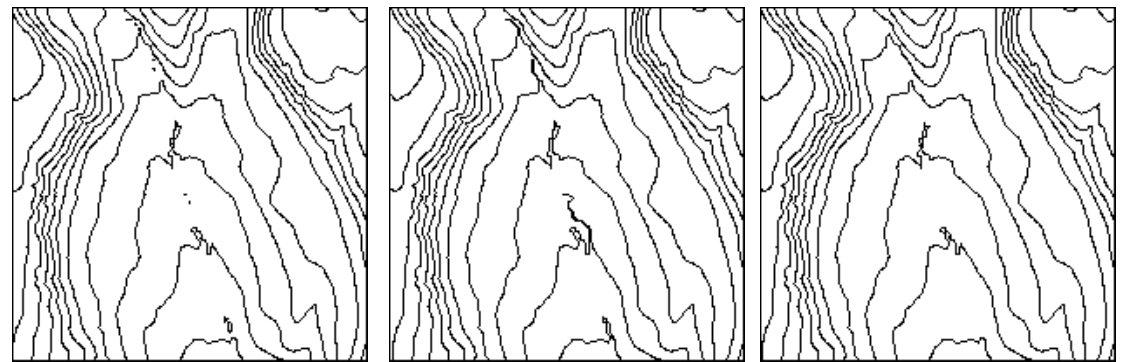
Figure 4. Relief with contour lines, Biokovo DTM5 (left - a), after the pit removal by carving method (middle - b) and after the pit removal by filling method (right - c)